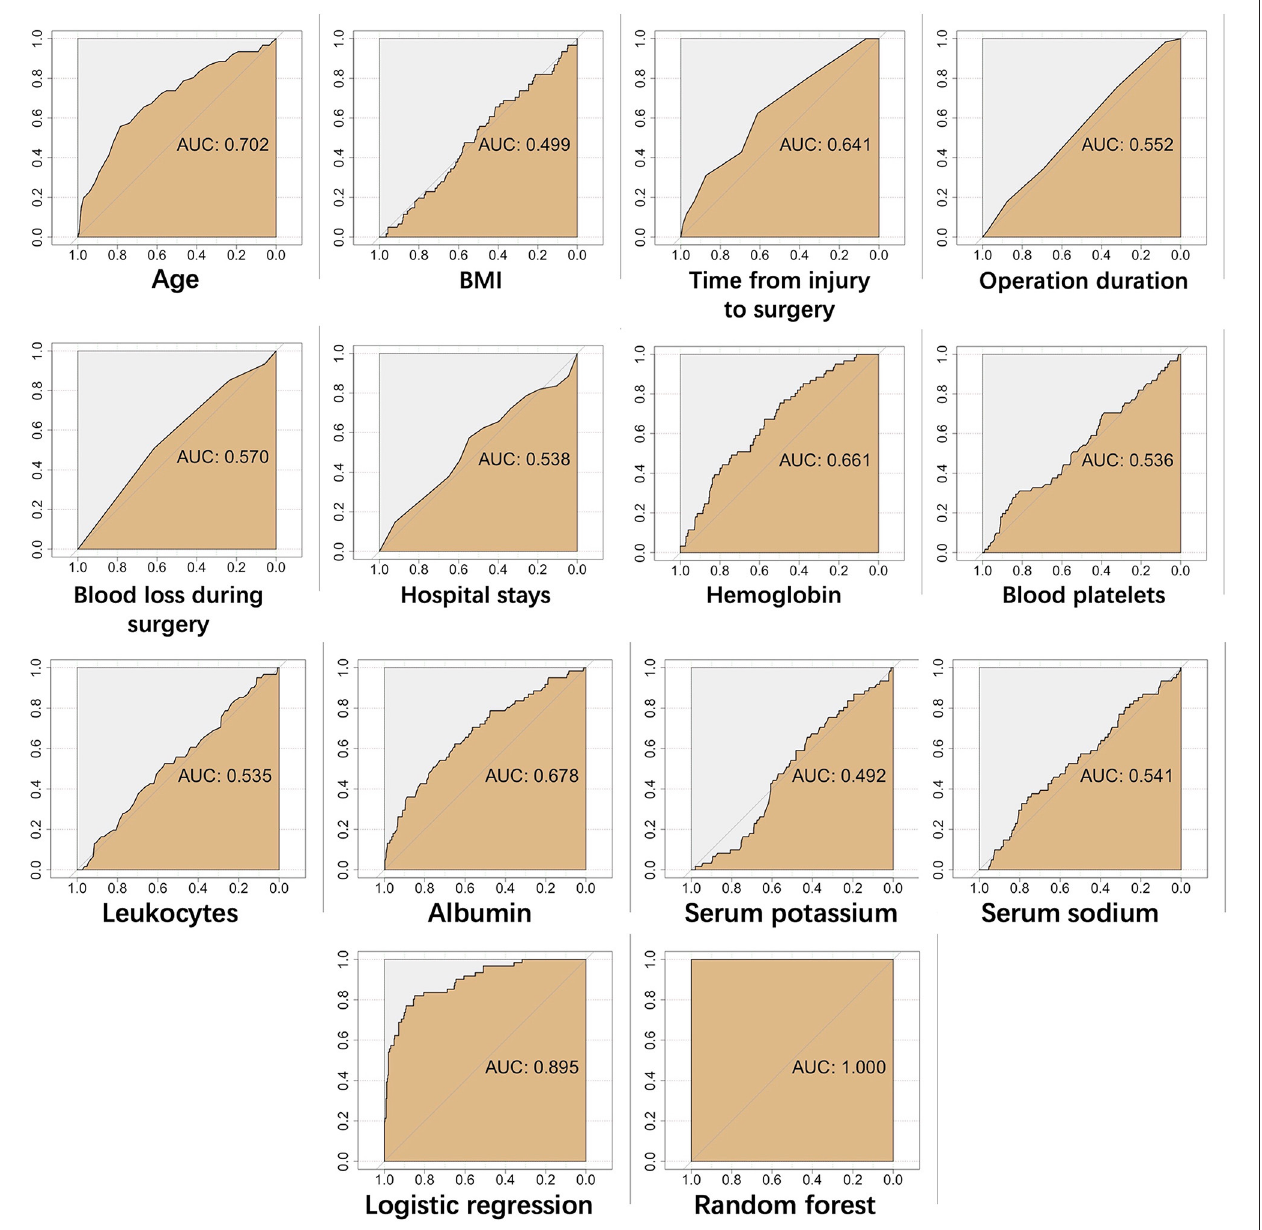
FIGURE 6 | The ROC curves of continuous variables, prediction model constructed by random forest algorithm, and traditional logistic regression in training